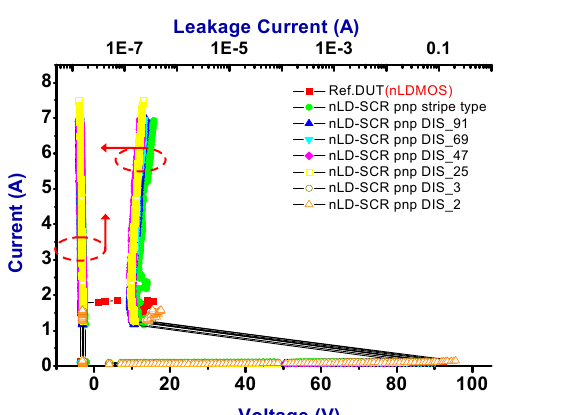
Figure 8. Snapback I-V curves and leakage currents of nLDMOS-SCR ( p-n-p -arranged) tested samples.